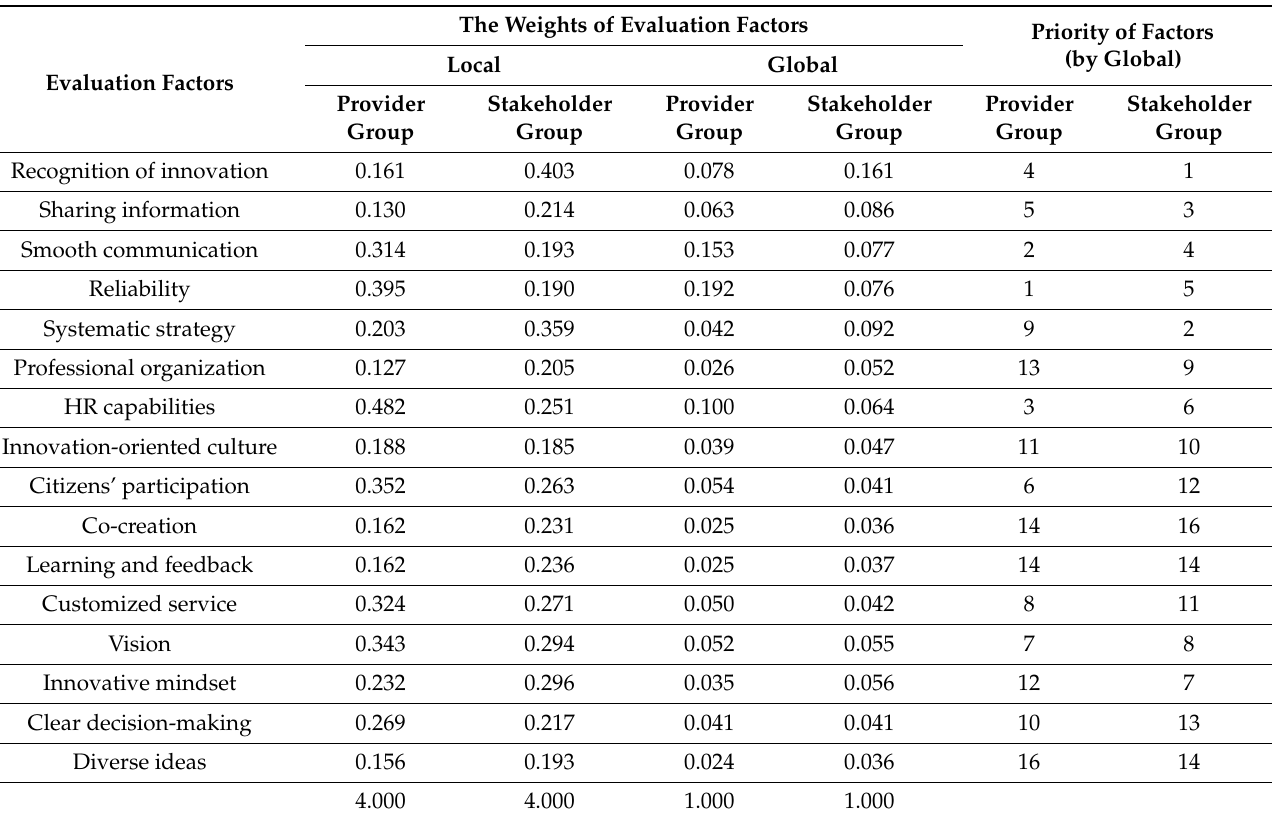
Table 8. Comparison analysis result on evaluation